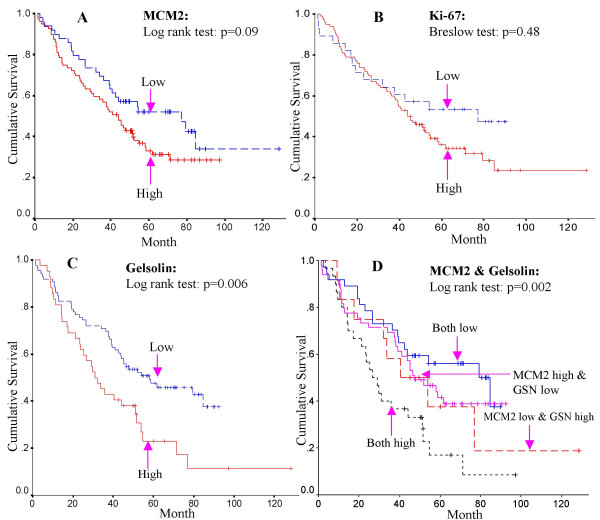
Kaplan-Meier Survival Curves for MCM2, Ki-67, and Gelsolin Expressions among 128 Patients with NSCLC. A: MCM2; B: Ki-67; C: Gelsolin; D: MCM2 & Gelsolin. Tick marks represent censored cases.